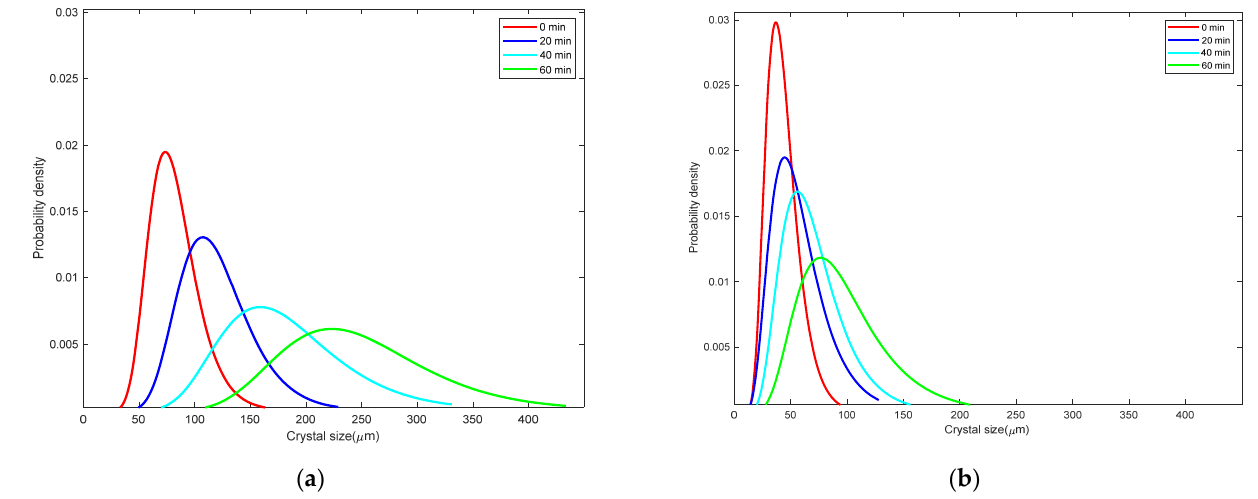
Figure 9. Evolution of β -form LGA crystal size distribution at four time points with a log-normal distributed model: ( a ) probability density of crystal length sizes; ( b ) probability density of crystal width sizes.